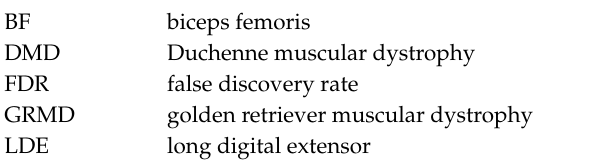
Figure S1: Heatmap analysis of all named metabolites from GRMD and control biceps femoris (BF) included in the t-test analysis. N = 4 control BF and N = 6 GRMD BF, Figure S2: Pathway analysis of GRMD biceps femoris t-test significant metabolites, Figure S3: Heatmap analysis of all named metabolites from GRMD and control long digital extensor (LDE) muscle included in the t-test analysis, Figure S4: Heatmap analysis of all named metabolites from GRMD and control long digital extensor (LDE) and biceps femoris (BF) muscle included in the One-Way ANOVA analysis, Figure S5: Untargeted metabolomics analysis of golden retriever muscular dystrophy (GRMD) biceps femoris (BF) and long digital extensor (LDE) muscle, Table S1: Non-targeted metabolomics performed on six month old control and age-matched golden retriever muscular dystrophy (a) biceps femoris used in t-test analysi; (b) long digital extensor used in t-test analysis; (c) long digital extensor or biceps femoris used in ANOVA analysis, Table S2: Significant metabolites included in combined gene and metabolite analysis in MetaboAnalyst3.0, Table S3: T-test Significant mRNA in GRMD by Microarray used in the combined gene and metabolite analysis in MetaboAnalyst